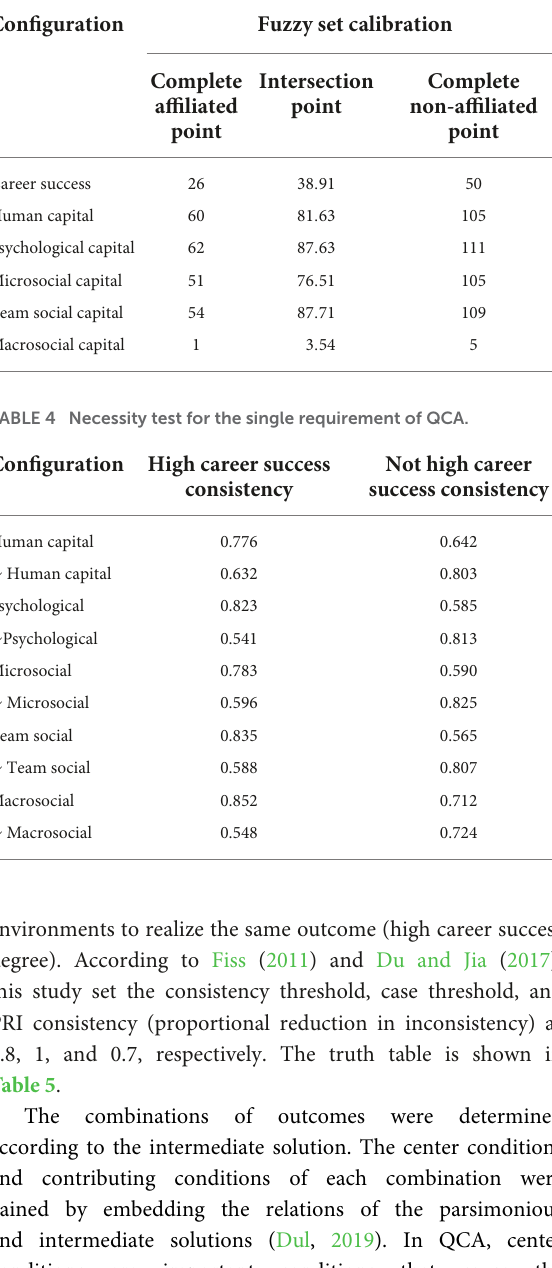
TABLE 3 Set and calibration statistics.